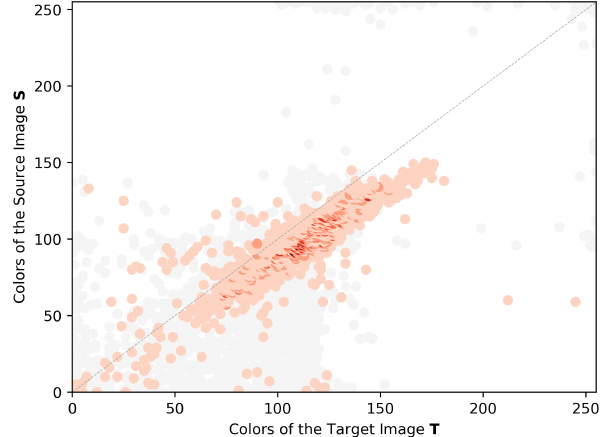
Figure 6. Example of a JIH of the red channel from a pair of images. The red dots represent the observations of the pairwise mappings in the red channel, and the color intensity represents the histogram count. The gray dots represent the discarded pairwise